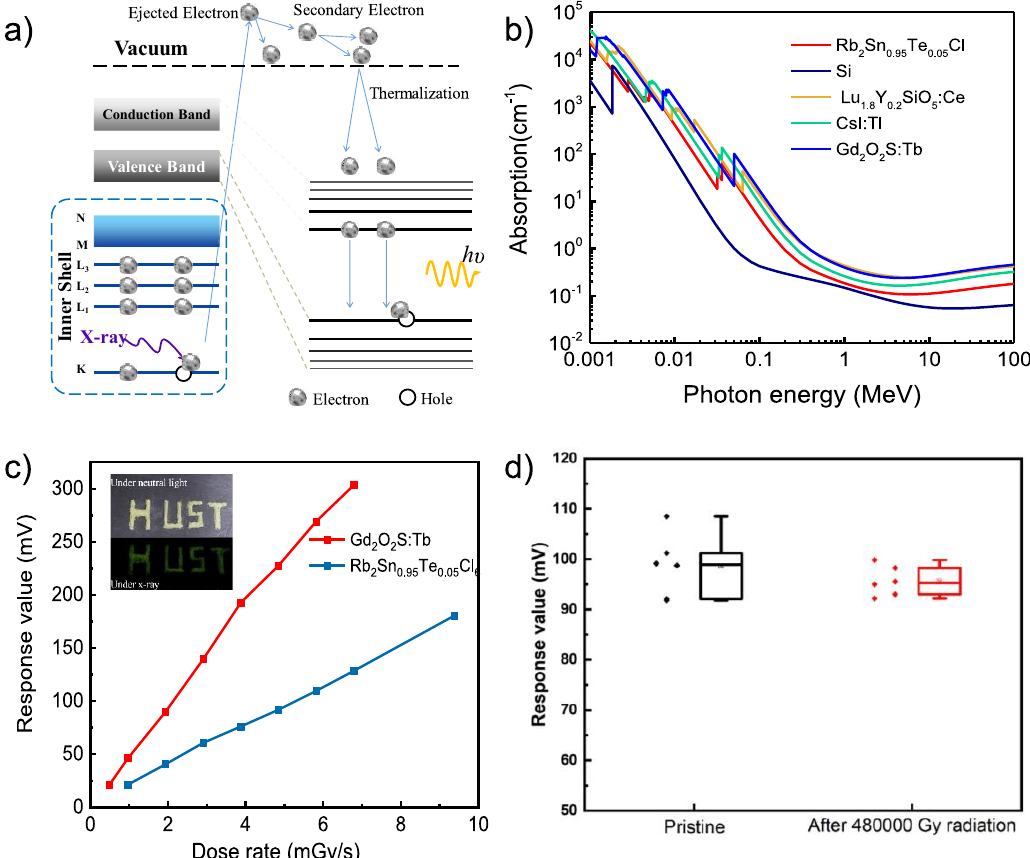
Figure 5: (a) Schematic diagram of the scintillation mechanism. (b) Absorption coefficients of Rb 2 Sn 0.95 Te 0.05 Cl 6 , Si, Lu 1.8 Y 0.2 SiO 5 : Ce (LYSO), CsI: Tl and Gd 2 O 2 S: Tb (GOS) as a function of photon energy, from 1 keV (soft X-rays) to 100 MeV (gamma radiation) (c) Response voltage of Rb 2 Sn 0.95 Te 0.05 Cl 6 and GOS as a linear function of dose rate. The inset is the photograph of Rb 2 Sn 0.95 Te 0.05 Cl 6 under neutral light and X-ray irradiation, separately. (d) Statistics of Rb 2 Sn 0.95 Te 0.05 Cl 6 scintillation response before and after radiation dose of 480,000